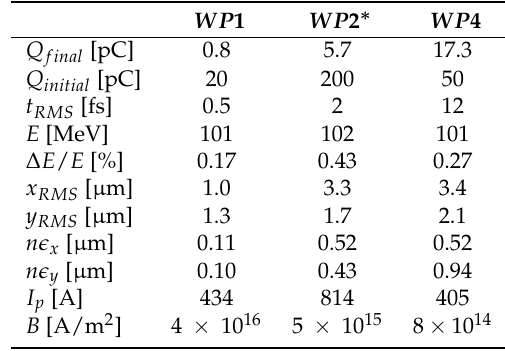
Table 5. Summary of the beam characteristics after the bunch compressor for three working points. The peak current I p is defined as I p = Q final / ( 3.5 · t RMS ) . The beam brightness is defined as B = I p / ( n (cid:101) x n (cid:101) y ) . In the column with (*) 2% of the particles in the tail were removed.